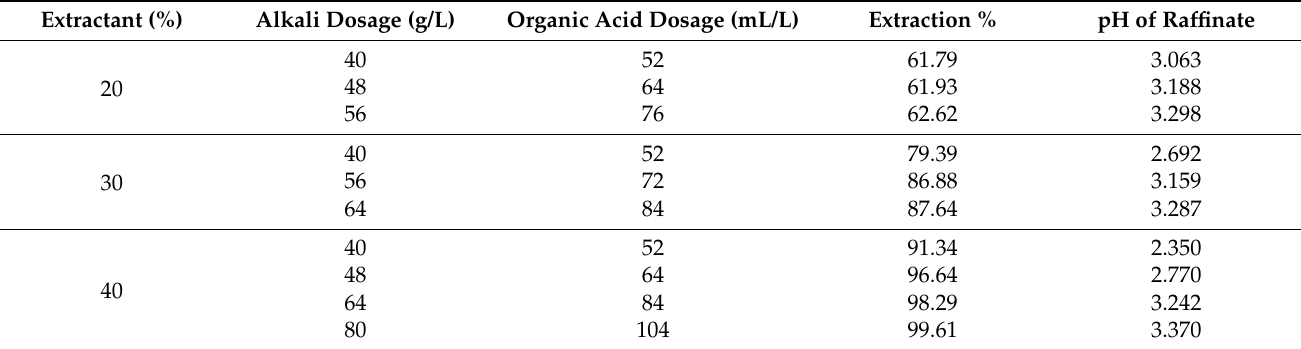
Table 6. The effect of D2EHPA extractant concentration on zinc extraction.